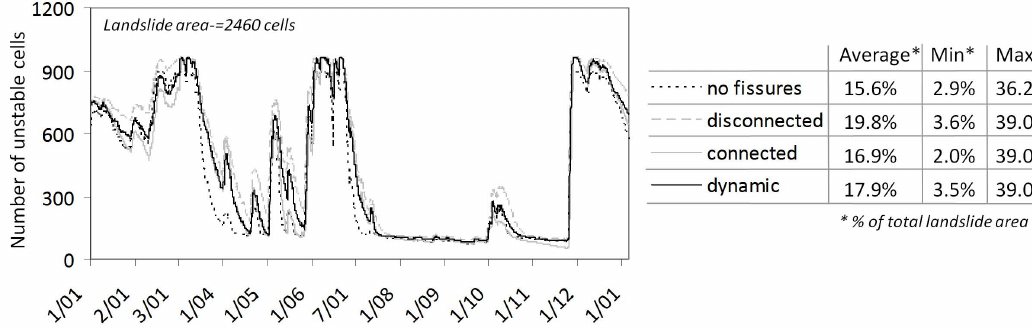
Fig. 7. The number of unstable cells ( f s < 1) per time step, simulated with different scenarios.